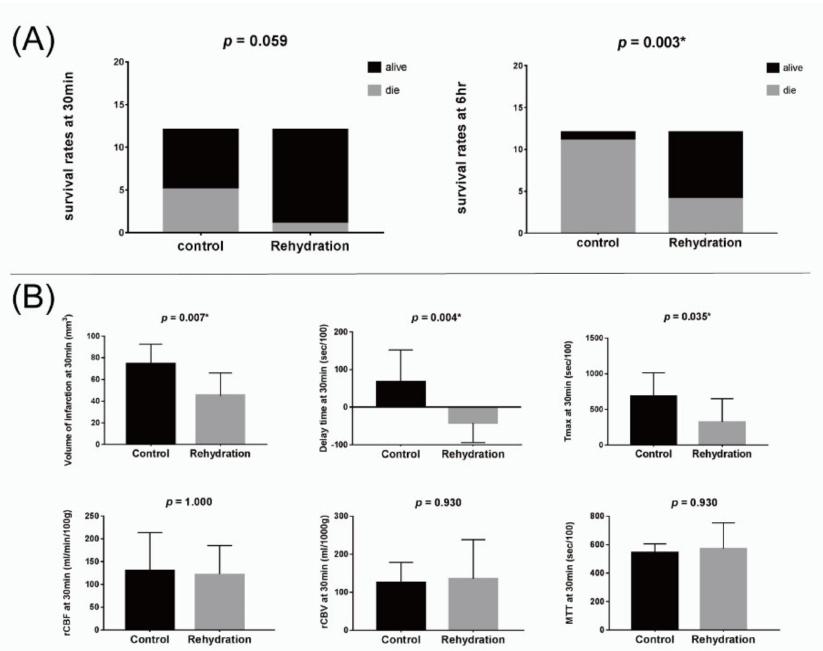
Figure 4. ( A ) Bar charts for the survival rates of the control and rehydration groups at 30 min (left) and 6 h (right) after surgery. ( B ) Bar charts for the perfusing indices of the control and rehydration groups at 30 min after surgery. * p <